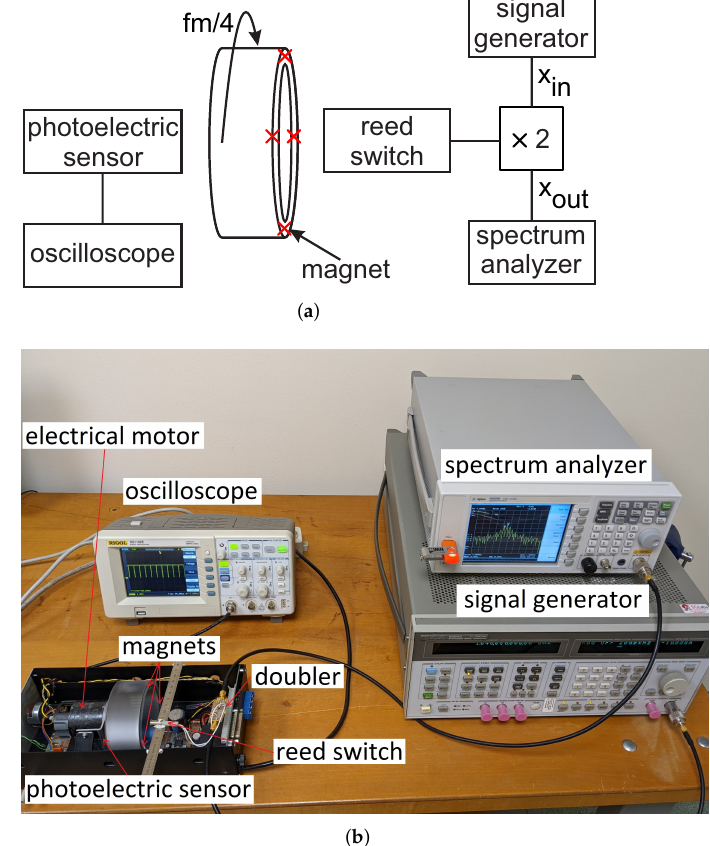
Figure 14. Frequency doubler modulated by a reed switch, used to monitor the rotational speed of an electric motor: ( a ) block diagram, and ( b ) photo of the experimental